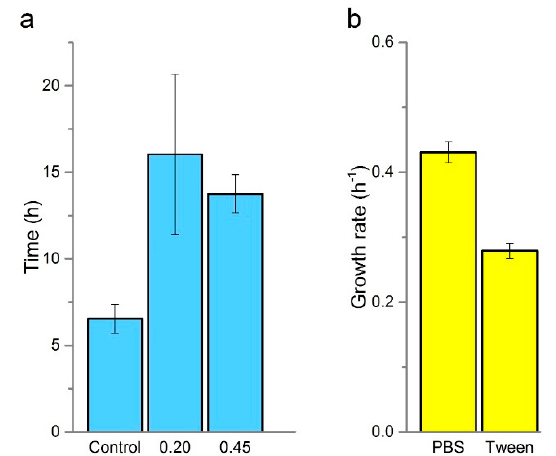
Figure 5. Detection time using the eluent obtained from the InnovaPrep ® concentrator, a 5 L sample c ontaining 5000 CFU of E. coli DSMZ 1576 was reduced to a volume of less than 1.0 mL and subsequently made up to volume (1.0 mL) ( a ). The effect on growth rate of E. coli DSMZ 1576 after being treated with Tween 20 for 45 min ( b ). Error bars represent the detection time range between replicates (n = 2–3).